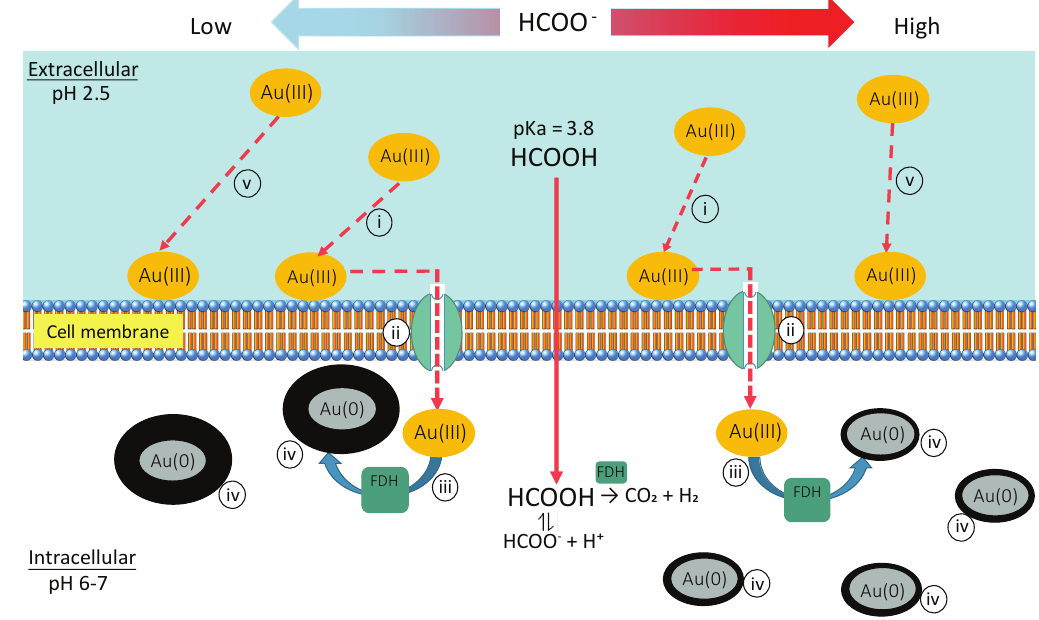
Figure 7. Proposed mechanism of bio-AuNPs production by Ac. aromatica : ( i ) Au(III) ions (in the form of AuCl 4 − ) are adsorbed onto the slightly positively charged cell surface. ( ii ) Au(III) ions are transported into cytoplasm via membrane “Au(III) tra ffi cking” proteins. ( iii ) Au(III) ions are reduced to form Au(0) nuclei via intracellular enzymatic reaction (possibly FDH) to decompose formate to produce H 2 as a reducing force ( iv ) At lower formate concentrations fewer Au(0) nucleation sites appear leading to greater crystal growth for individual particles, whereas at higher formate concentrations the number of Au(0) nuclei is increased leading to smaller crystal growth for individual particles. ( v ) As the flow from ( i ) to ( iv ) proceeds, remaining Au(III) ions left in the bulk solution can sequentially adsorb on the cell surface by occupying a vacancy created upon tra ffi cking of the former adsorbate into the cytoplasm, to further proceed to